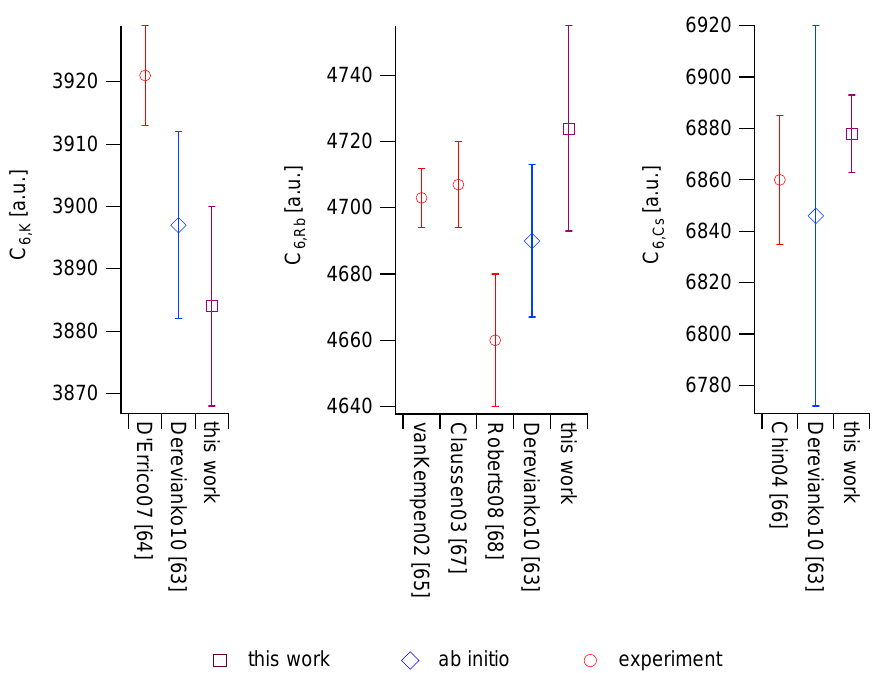
Figure 6. Theoretical [63] and experimental [64–68] C 6 values of K, Rb, and Cs from several different sources and the C 6 values determined in this article from polarizability measurements [3]. The experimental C 6 values were all determined from Feshbach resonance